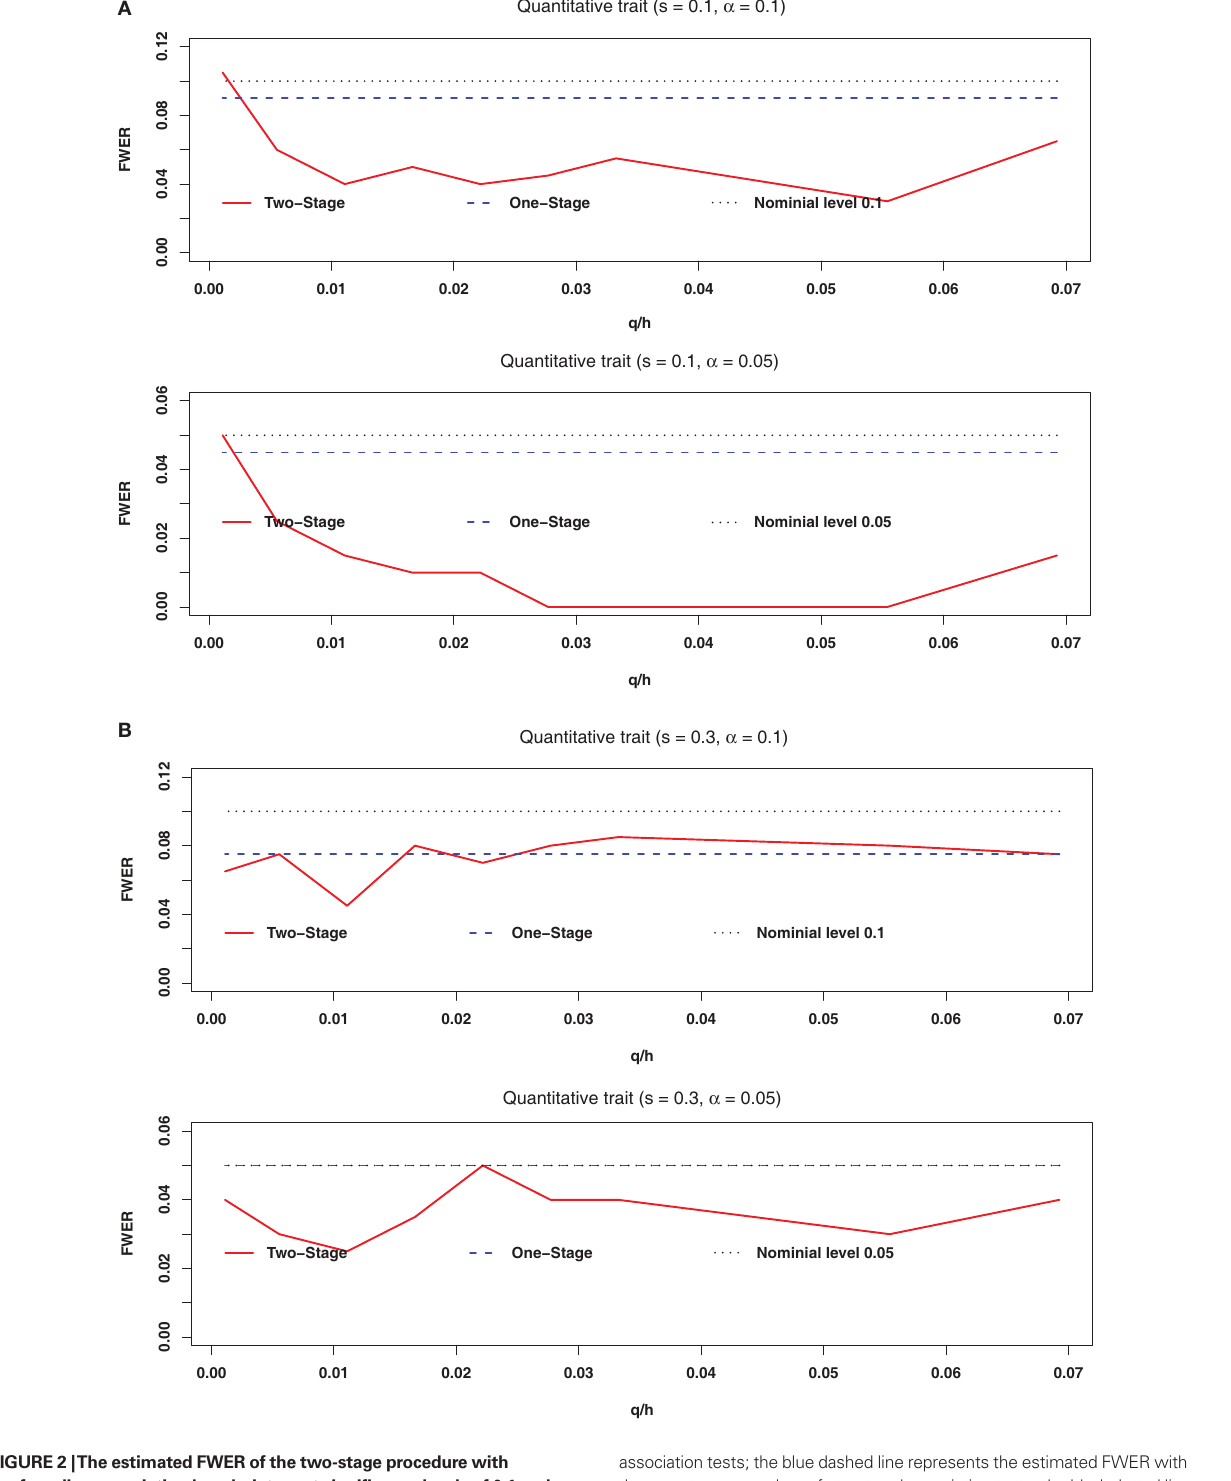
association tests; the blue dashed line represents the estimated FWER with the one-stage procedure of structured association tests; the black dotted line represents the nominal level; q is the number of SNPs selected in the first stage; and h is the number of total